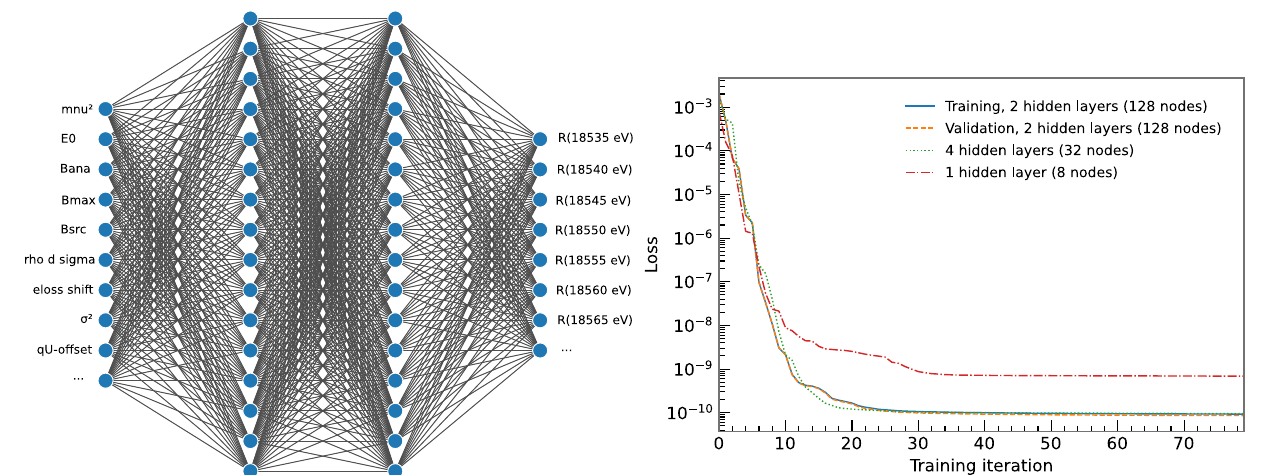
Fig. 3 Left:layerstructureofourneuralnetwork.Theinputlayer(left) consists of the parameter values of the spectral parameters such as the neutrino mass squared. Two hidden layers (number of nodes not to scale for better visualization) connect the input layer with the output layer using “mish” as activation function. The output layer (right) gives the count rate at each scan step with a different retarding potential. Right: traininglossoveriterationforthedifferentsamples.Training(bluesolid line) and validation (orange dashed line) are for our reference architec-